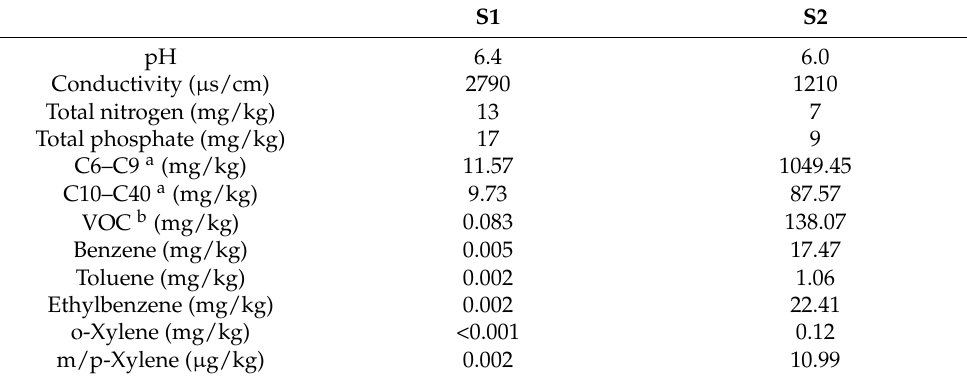
Table 1. Physicochemical properties of the soil